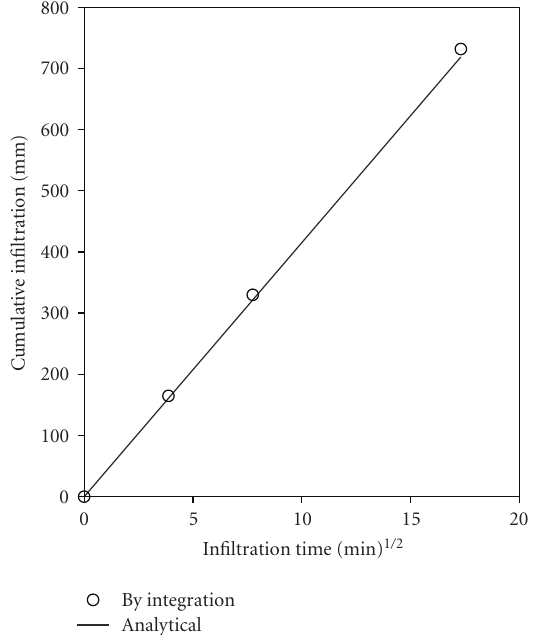
Figure 2: Cumulative water infiltration analytically estimated from (46) and observed data obtained integrating soil water profiles presented in [1].